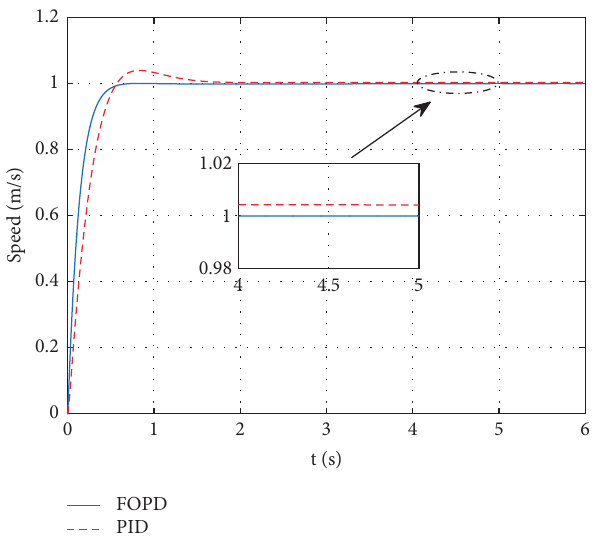
Figure 7: Speed regulation